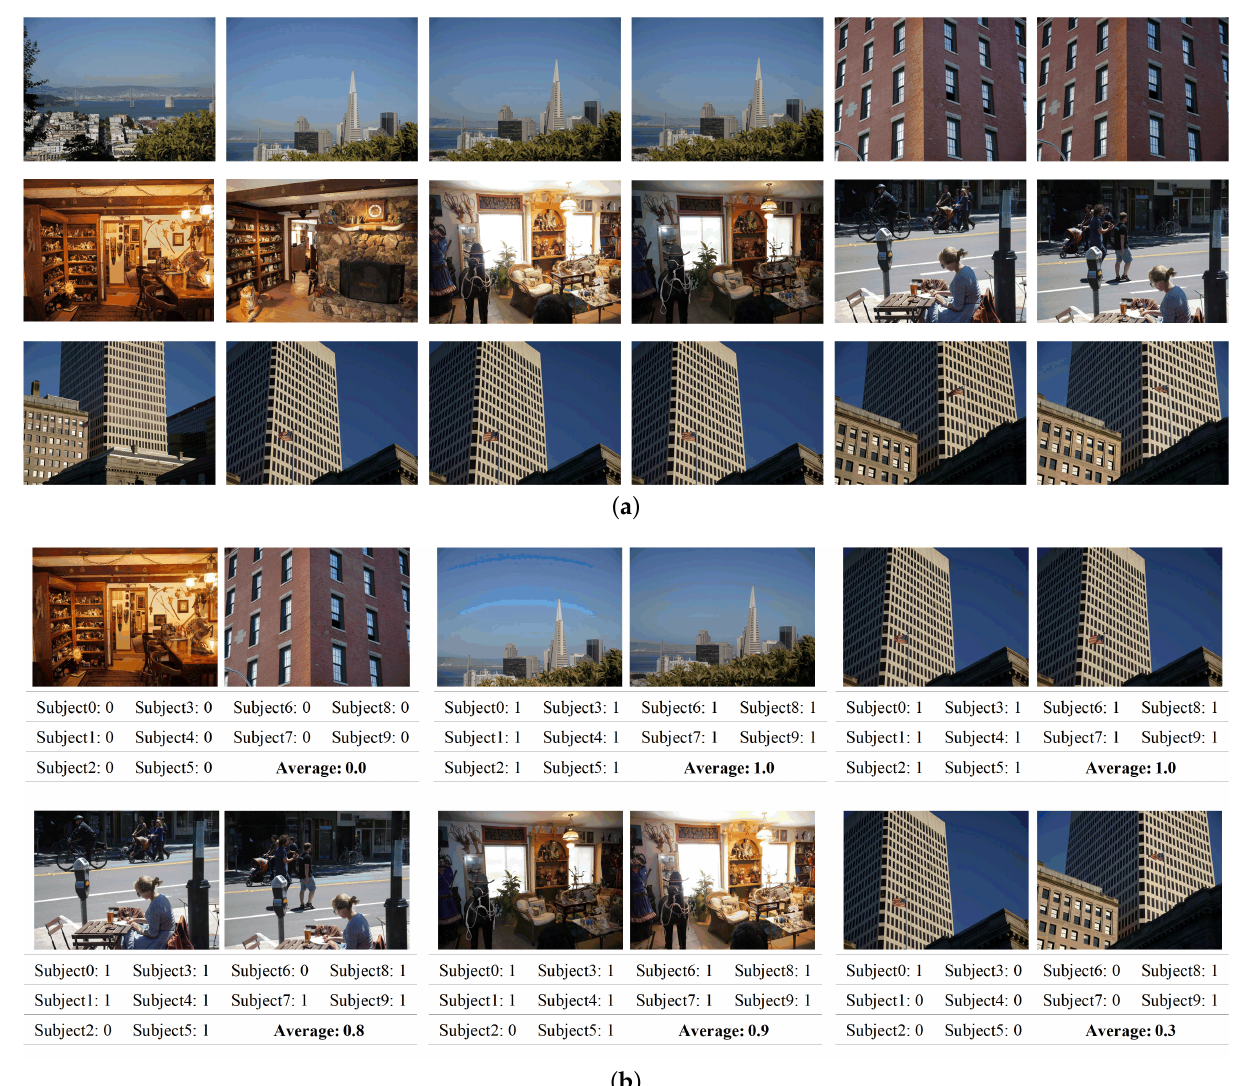
Figure 3. Illustration of examples from CaliforniaND (ND = near duplicate). ( a ) Raw photos in CaliforniaND. ( b ) Image pairs with their binary annotations and the average probability to be a near duplicate image pair. In the first row, three samples are given by all subjects with the same binary label, which are obvious near duplicate/non-duplicate image pairs. The second row shows pairs that are not extremely visually similar. The changes between pairs, which are considered as near duplicate averagely, include rotation and translation of views, target changes, and camera exposure setting